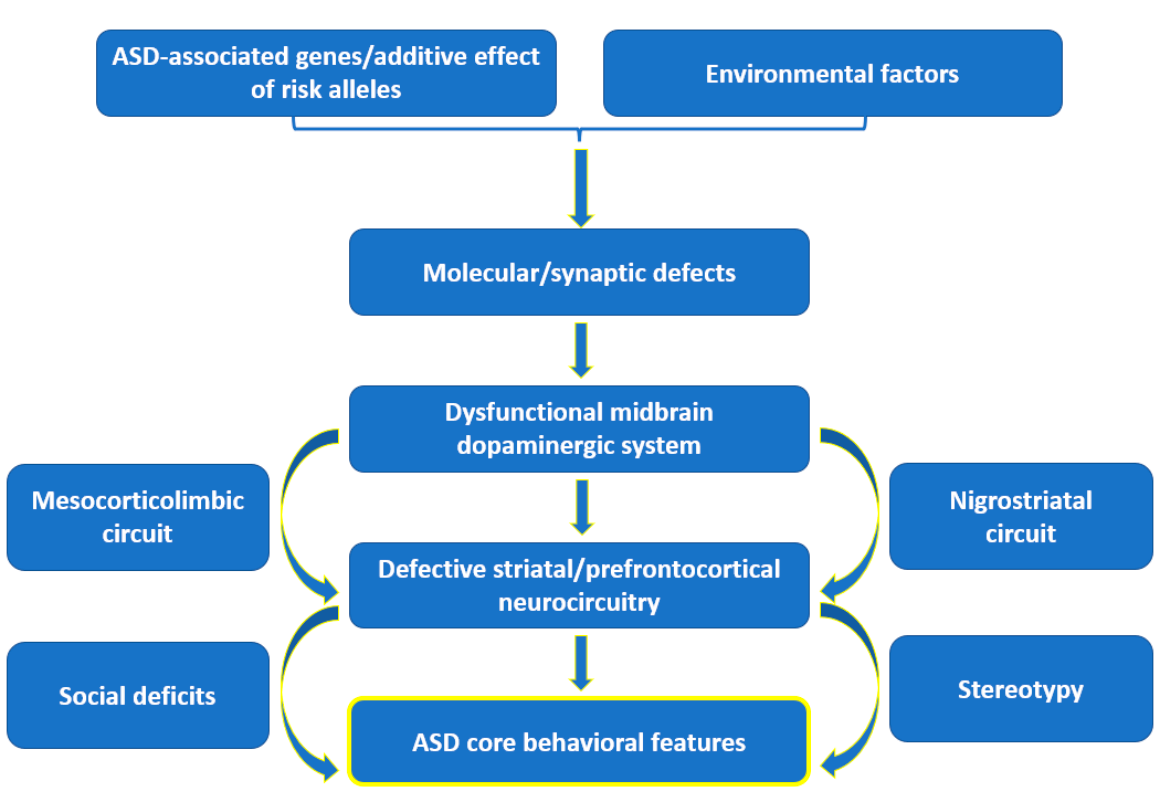
Figure 4. Schematic representation of the dopamine hypothesis. Created based on information from [102,103].